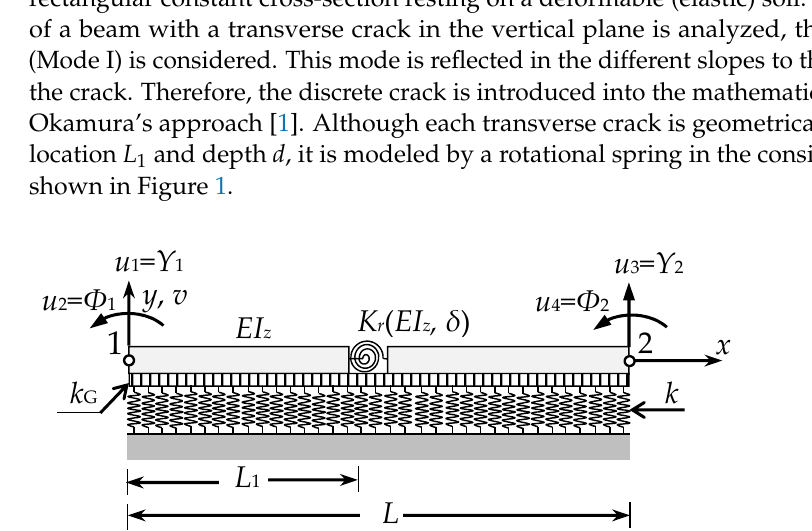
Figure 1. Mathematical model of a beam with crack on the two-parametric soil. Okamura et al. defined the genuine spring stiffness K r